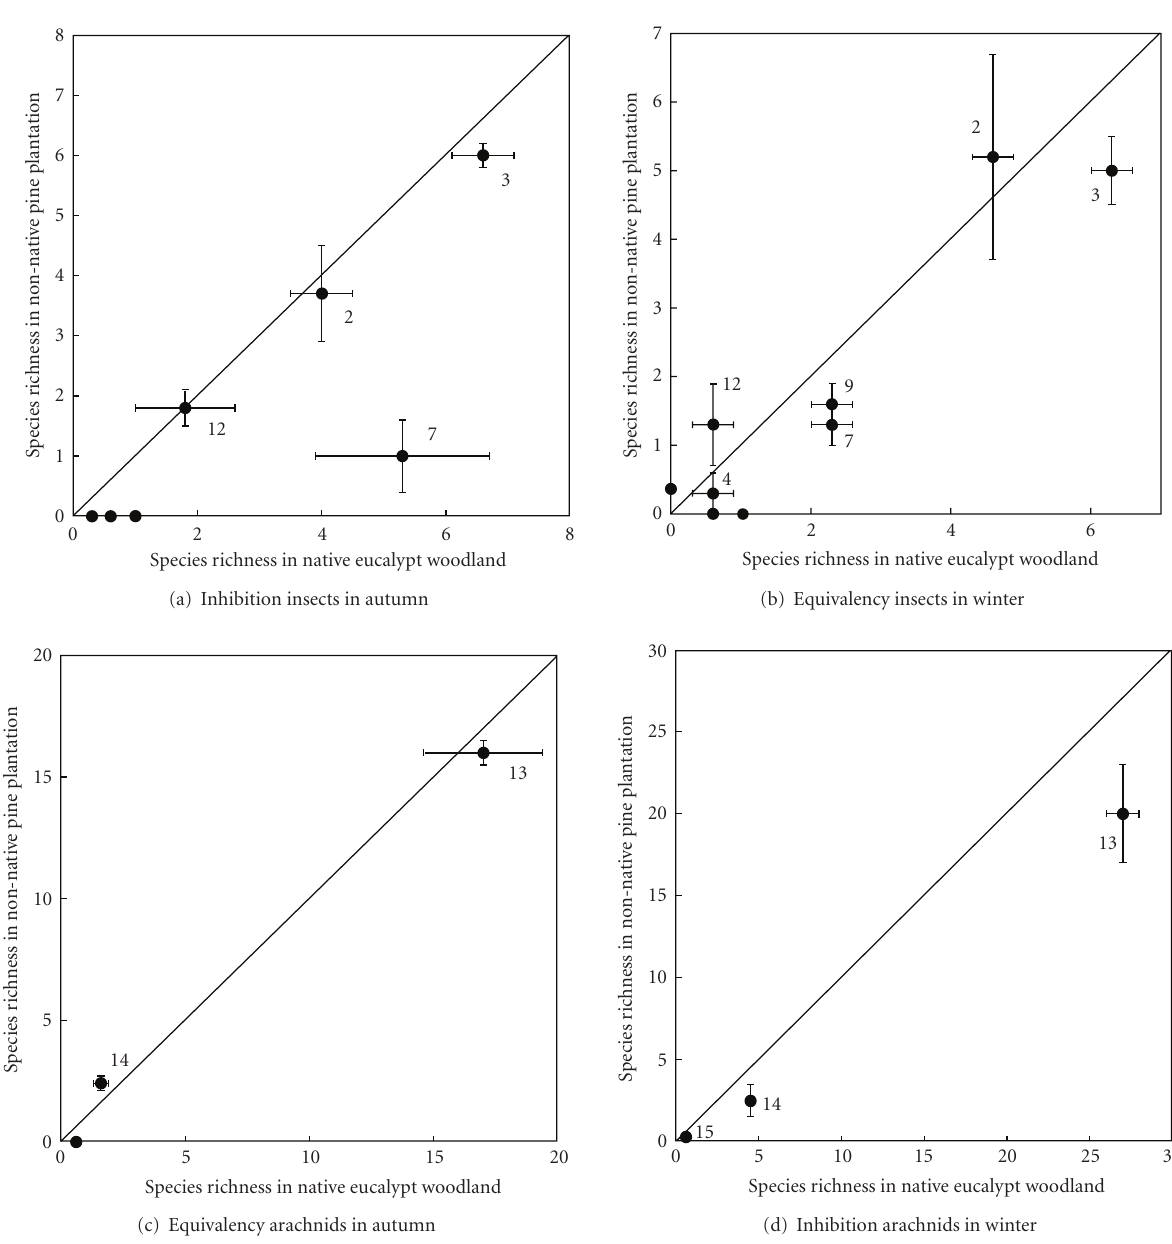
Figure 1: Values of species richness ( ± SE) for multiple taxonomic components of insect and arachnid assemblages in native eucalypt woodland and exotic pine plantations. (a) insects in autumn, (b) insects in winter, (c) arachnids in autumn, (d) arachnids in winter. Orders numbered on graphs are Blattodea 1 , Coleoptera 2 , Collembola 3 , Diptera 4 , Embioptera 5 , Hemiptera 6 , Hymenoptera 7 , Isopoda 8 , Lepidoptera 9 , Neuroptera 10 , Orthoptera 11 , Psocoptera 12 , Acari 13 , Araneae 14 , and Pseudoscorpiones 15 . In (a), Orders 1, 4, 6, 9, 10, and 11 are absent from pine plantation sites (zero values on y -axis) but represented in eucalypt woodland sites by a small number of species. In (b), Orders 1 and 6 are absent from pine plantation sites but represented in eucalypt woodland sites by a small number of species. Note that in (b), Orders 5 and 8 are absent from eucalypt woodland sites but represented by a small number of species in pine plantation sites. In (c), Order 15 is absent from pine plantation sites but represented in eucalypt woodland sites by a small number of